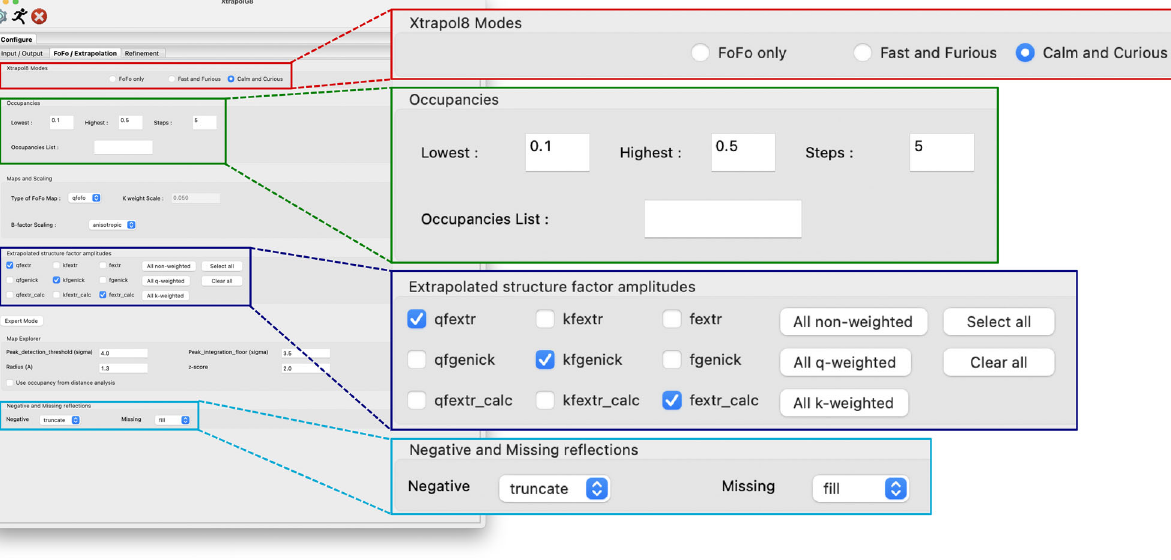
Fig. 2 The graphical user interface allows facilitated parameter control. Panel of the GUI in which the user can alter the options concerning the Fourier difference maps and ESFAs, with zoom-in on some input fi elds. Details on all input and output tabs and panels is provided in Supplementary Figs. 1 – e.g., the plots of R iso and CC iso (see below) as a function of reso-